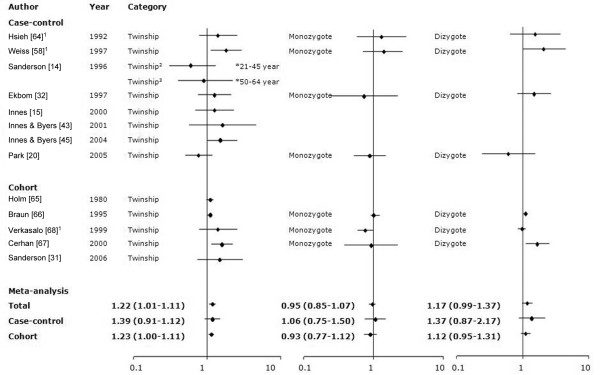
Meta-analysis for the association between twinship and risk for breast cancer. The tests for homogeneity and for publication bias in the studies analyzed are as follows. Twinship: Q = 18.79 (13 degrees of freedom), P = 0.13; Begg test, P = 0.78; Egger test, P = 0.24. Monozygote twin: Q = 5.79 (6 degrees of freedom), P = 0.45; Begg test, P = 0.55; Egger test, P = 0.85. Dizygote twin: Q = 12.53 (6 degrees of freedom), P = 0.06; Begg test, P = 1.0; Egger test, P = 0.3. 1The authors used the female twins as the proxy for the monozygote twin and the female twin with male twin as the proxy for the dizygote twin. 2Women aged 21 to 45 years. 3Women aged 50 to 64 years. CI, confidence interval; OR, odds ratio.